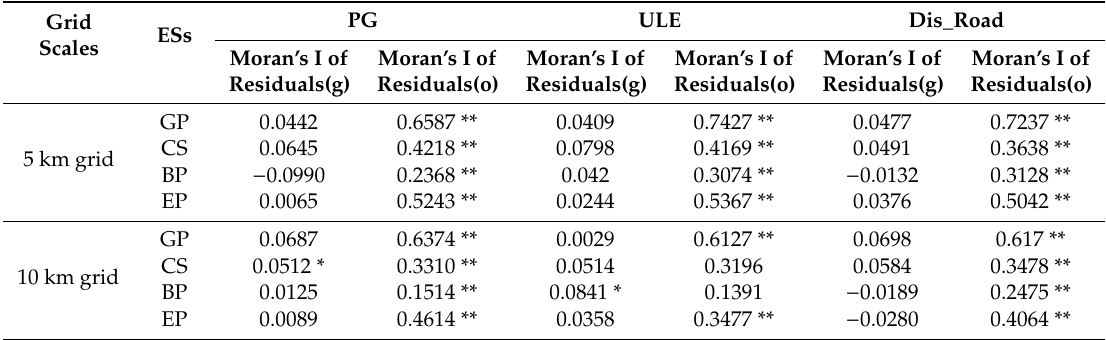
Table 5. Moran’s I of model residuals for ordinary least squares (OLSs) and geographically weighted regressions (GWRs) for the relationships between ecosystem services changes and urbanization